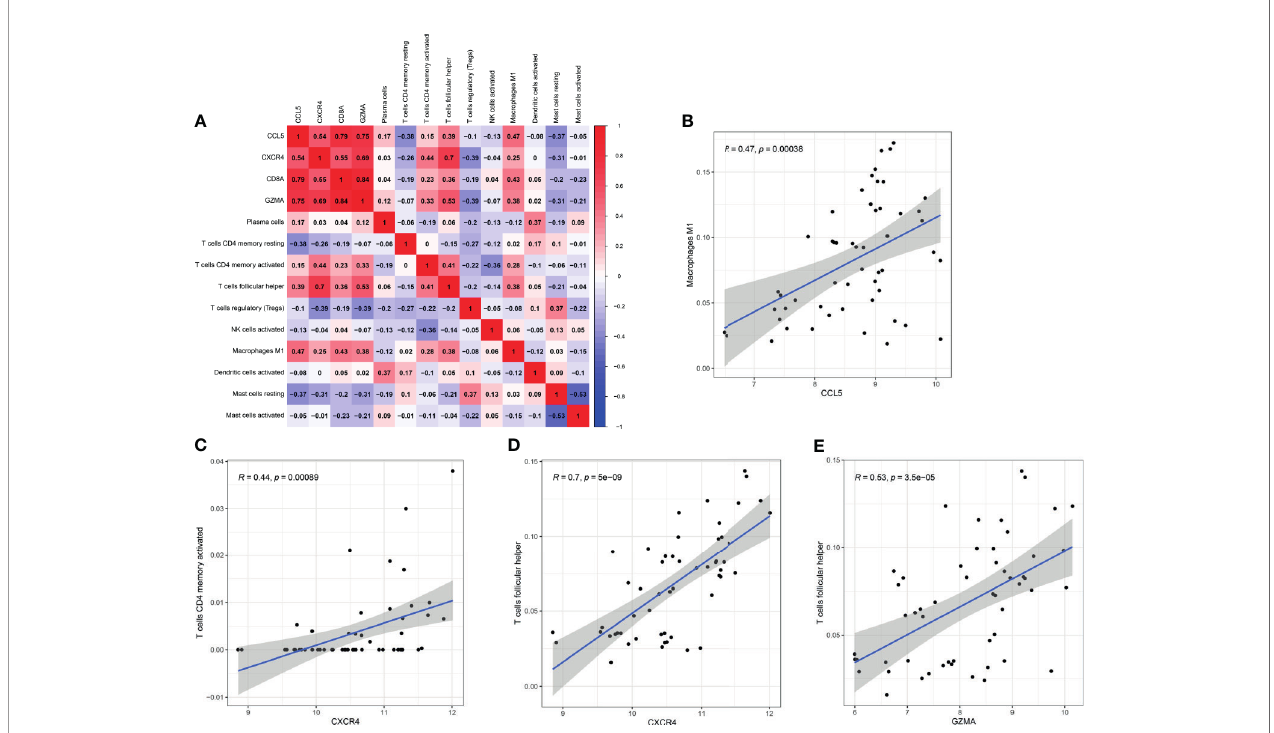
FIGURE 9 | Correlation between biomarkers and differential immune cells in RA. (A) Correlation among four effective biomarkers and 10 signi fi cantly differential immune cells. (B – E) Signi fi cantly related biomarkers and immune cells by R > 0.40 and p <